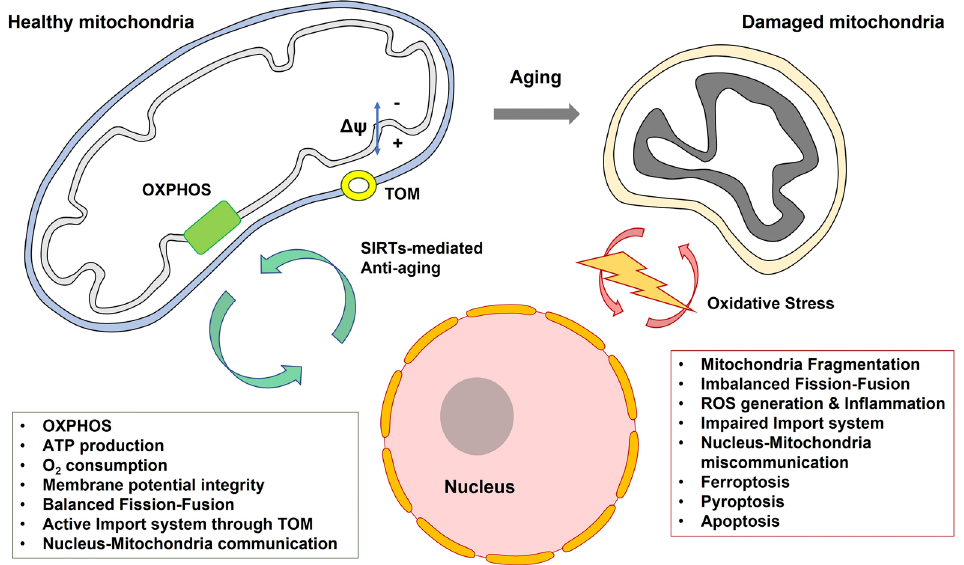
Figure 4. Communication between mitochondria and nucleus can be diminished by aging. Abbrevi- ation . OXPHOS, oxidative phosphorylation; TOM, the translocase of the outer